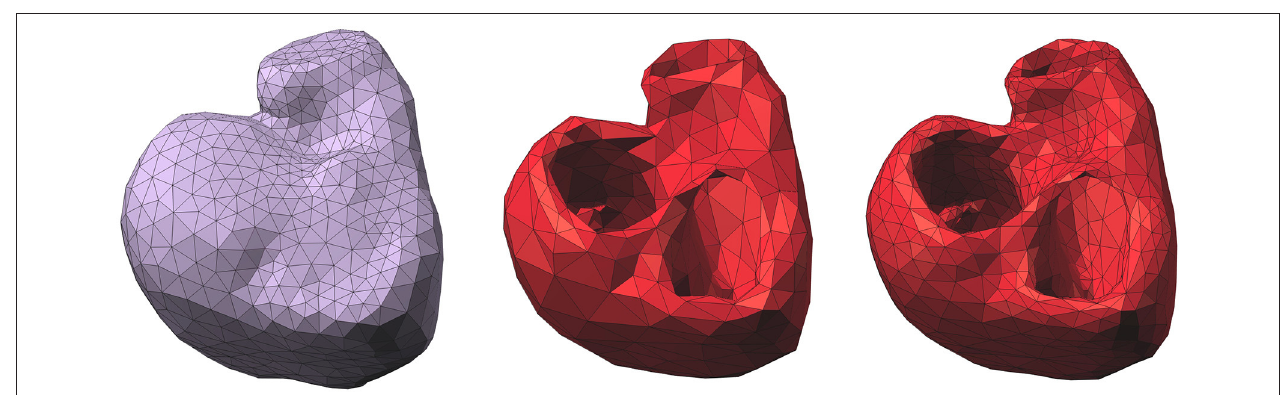
FIGURE 2 | Left : epicardium-only mesh ( Mesh1 ); middle : endocardial and epicardial mesh ( Mesh2 ); right : refined mesh of Mesh2 . Right posterior oblique view.